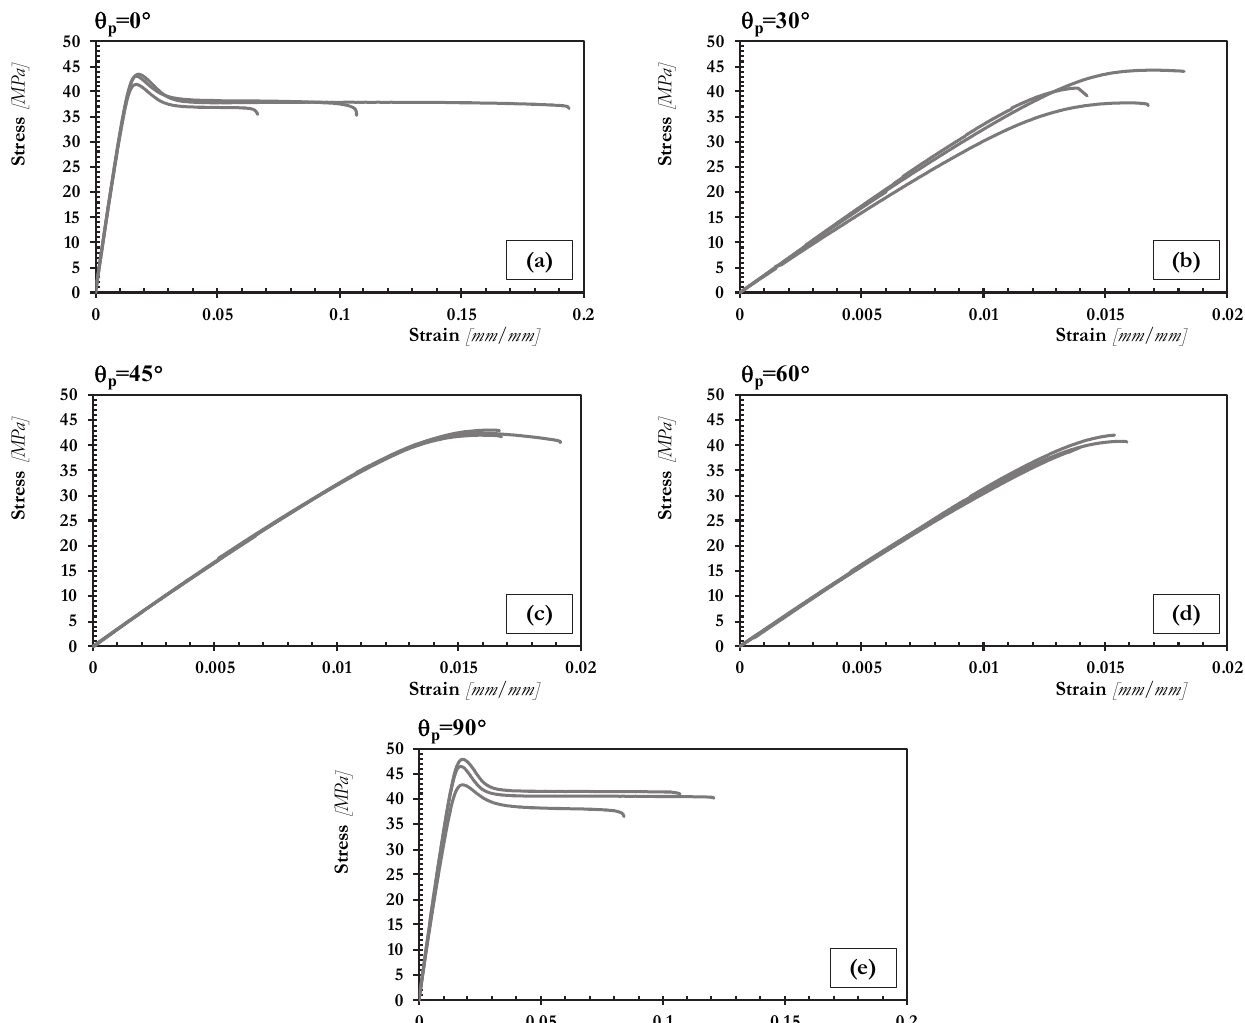
Figure 3: Experimental stress vs. strain curves generated by testing plain samples manufactured by adopting different values for manufacturing angle θ p